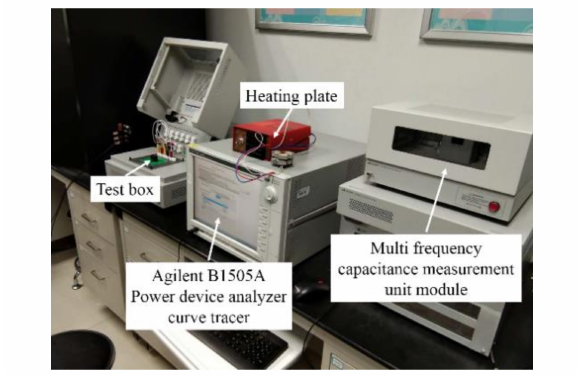
Figure 6. Static characteristic test platform for power